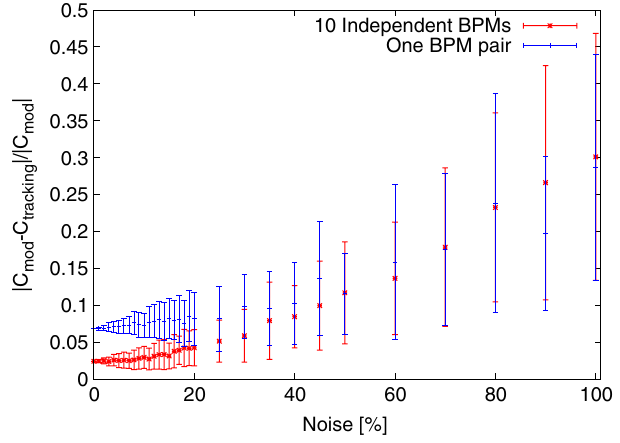
FIG. 9. The simulated performance of a system using several BPMs but only with the 1BPM method compared to a two BPMs at a single location separated with a phase advance of π